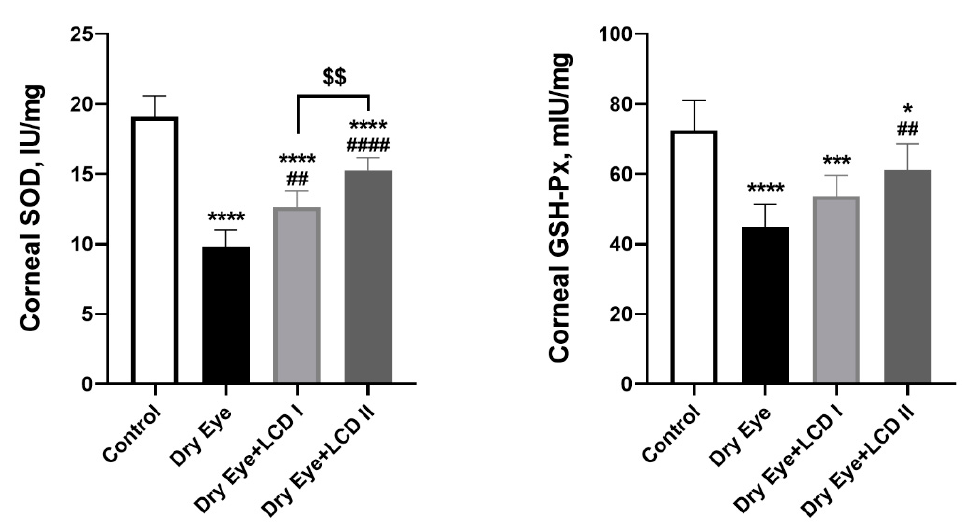
Figure 4. Effect of the combination of lutein/zeaxanthin, curcumin and vit D (LCD) on serum malondialdehyde (MDA), corneal MDA, corneal superoxide dismutase (SOD), and corneal glutathione peroxidase (GSH-Px), in benzalkonium chloride (BAC)-induced dry eye syndrome in rats ( n = 7 per group). Control: No treatment; Dry Eye: BAC-induced dry eye syndrome; LCD I; Dry Eye + LCD I: BAC-induced dry eye syndrome plus LCD I (100 mg/kg body weight); Dry Eye + LCD II: BAC-induced dry eye syndrome plus LCD II (200 mg/kg body weight). Data are presented as a bar with means and standard deviations. (ANOVA and Tukey ′ s post-hoc test. Statistical significance between groups is shown by: * p < 0.05; ** p < 0.01; *** p < 0.001; **** p < 0.0001 compared as control group; ## p < 0.01; ### p < 0.001; #### p < 0.0001 compared as Dry Eye group; $ p < 0.05; $$ p < 0.01 compared